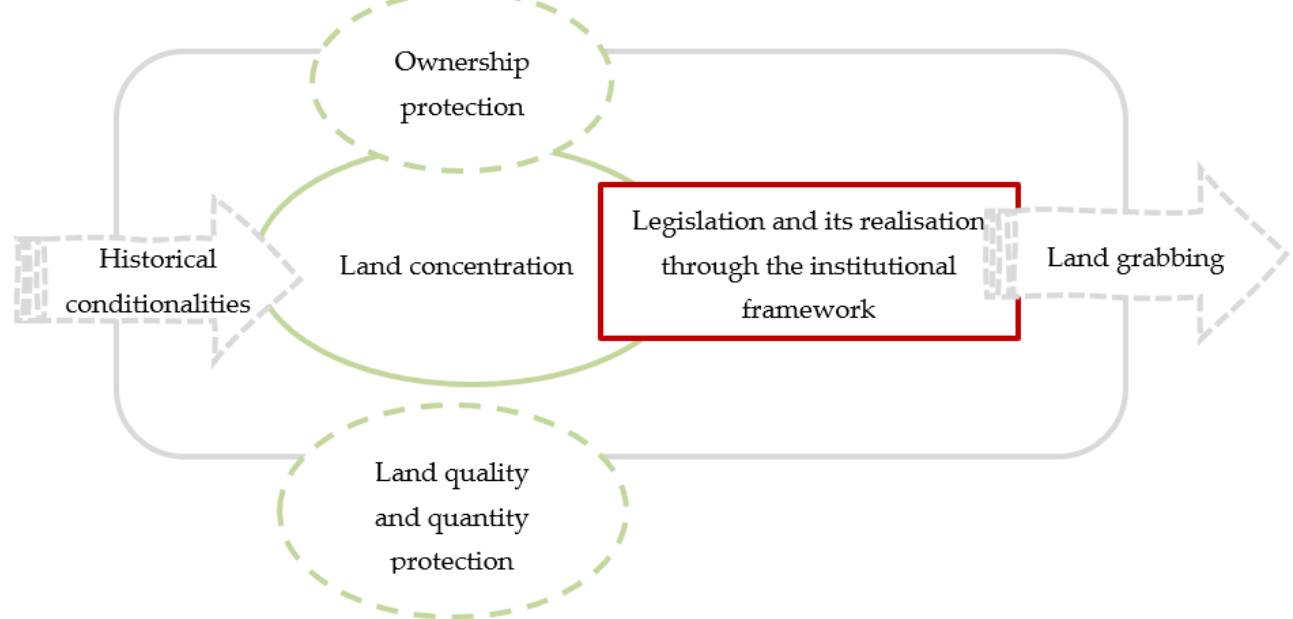
Figure 2. Context of the examined connections leading to the threat of land grabbing in Slovakia. Source: own representation, 2021.